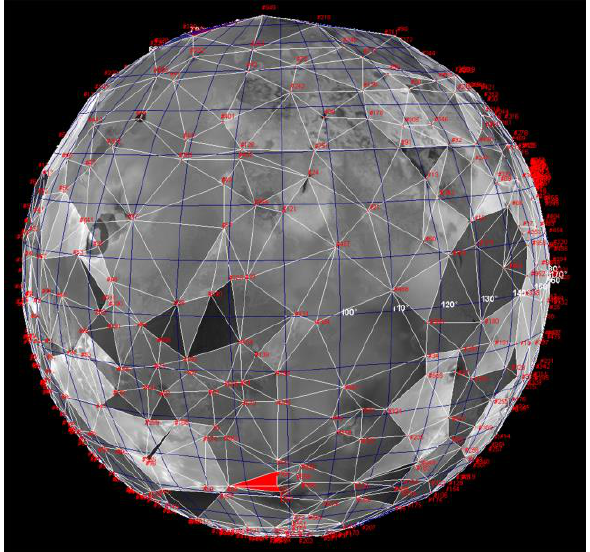
Figure 4. Control point measurements for Galilean satellite Io based on images with various conditions obtained by Voyagers and Galileo at different time, and preliminary processed in TiePointsTransform